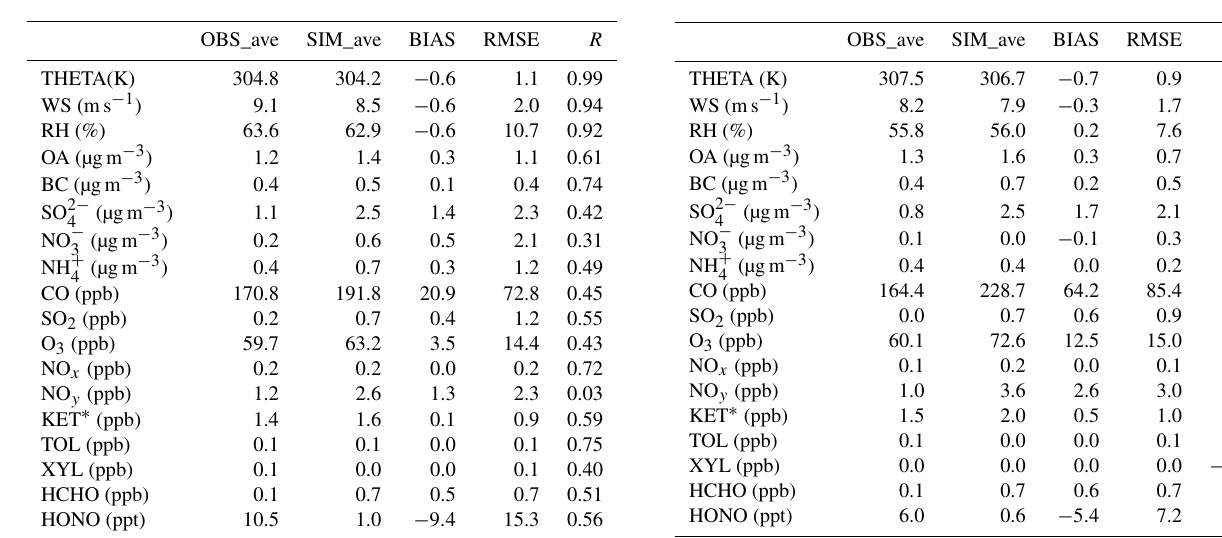
Table 2. Observed (OBS_ave) and simulated (SIM_ave) mean val- ues for bias (BIAS), root mean square error (RMSE), and correla- tion coefficients ( R ) for EMeRGe HALO flights on 17 and 19 March 2018. KET ∗ : the observed acetone is applied to compare with sim- ulated ketones (KET).